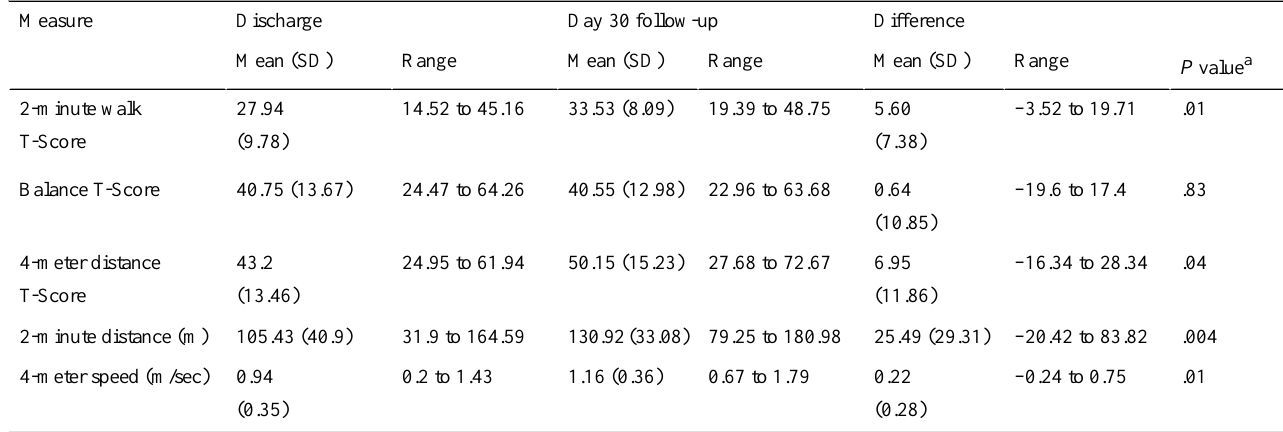
Table 2. Mobility performance tests at Discharge and Day 30. Scores adjusted for age, sex, race/ethnicity, and education. Average T-Score is 50; higher scores indicate better performance. 2-Minute Walk Test is a measure of endurance; 4-Meter Distance Test is a measure of gait speed.